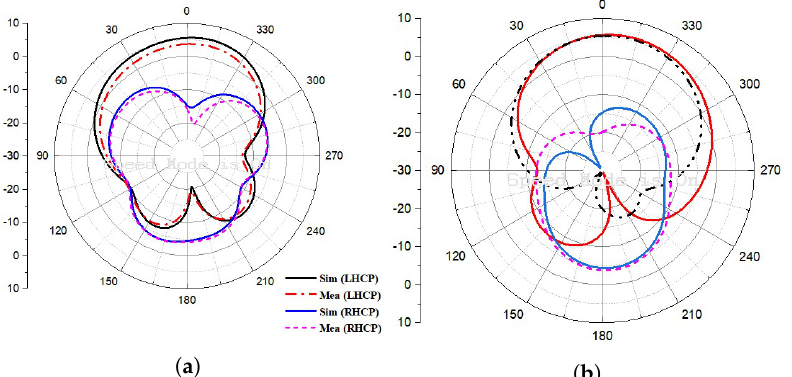
Figure 15. Simulated and measured radiation pattern that occur when port-1 is excited and port-2 is terminated. ( a ) E-plane LHCP and RHCP. ( b ) H-plane LHCP and